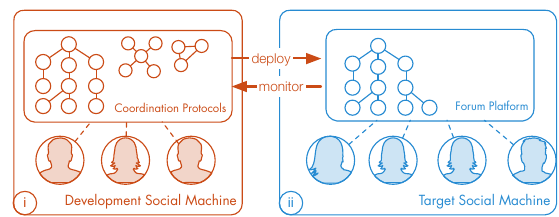
Figure 1. Two connected social machines: i) the development social machine, where crowdsourced workers follow coordination protocols to create a software artefact; ii) the target social machine, where a community of practice forms around the software artefact created by i).